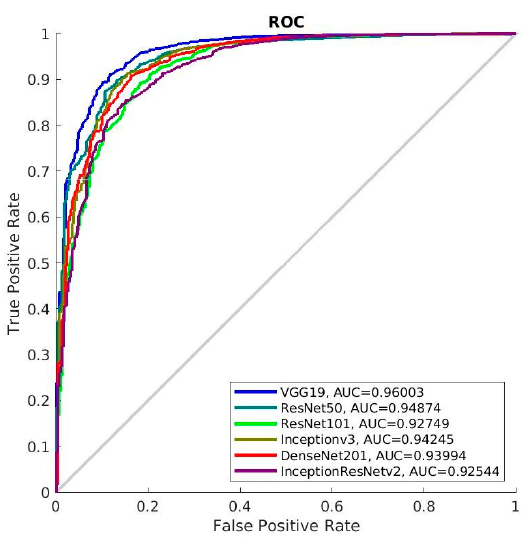
Table 4. The performance of the deep-learning models on mass classi fi cation when trained on the original training set.